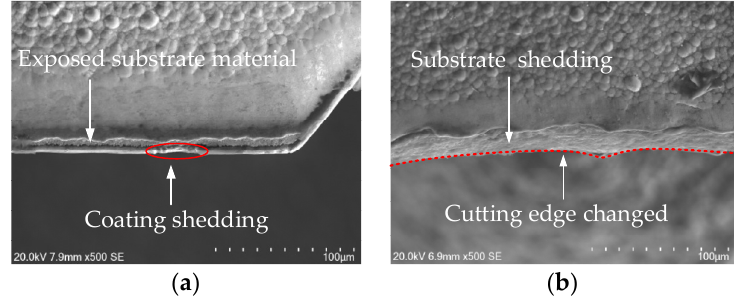
Figure 4. The tool wear morphology when the milling length was 44 m, ( a ) the wear morphology of the rhombic milling cutter and ( b ) the wear morphology of the staggered helical milling cutter.